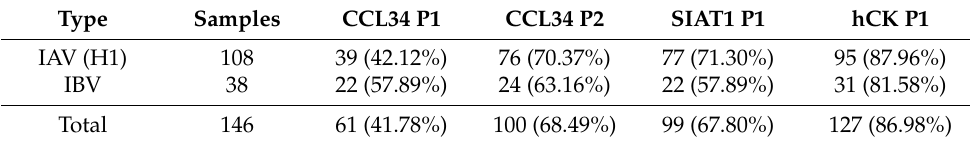
Table 1. Isolation of clinical samples positive to influenza B virus in different MDCK